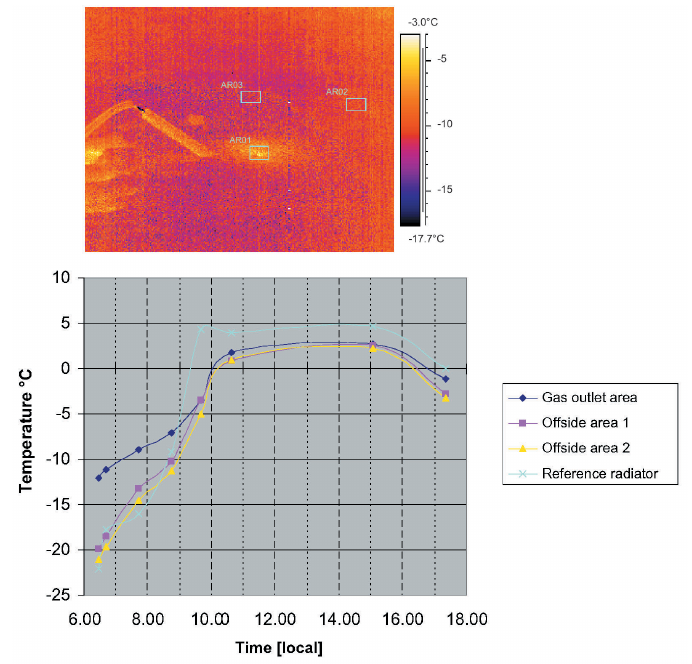
Fig. 9. Temperatures as function of time during 20th February 2003 of snow scene above; gas outlet and two offside areas are marked, reference radiator is visible as warm rectangular spot above middle of